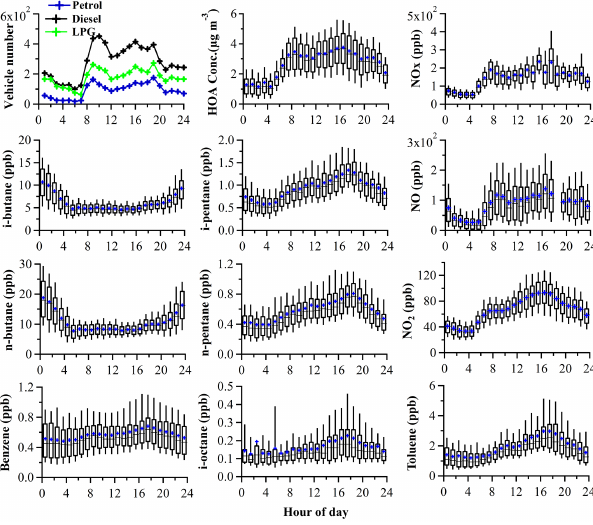
Figure 5. Diurnal patterns of vehicle numbers at the Mong Kok site during 28–31 May 2013 and concentrations of HOA, NO x , NO 2 , NO, i-pentane, n-pentane, i-octane, i-butane, n-butane, benzene and toluene during the whole